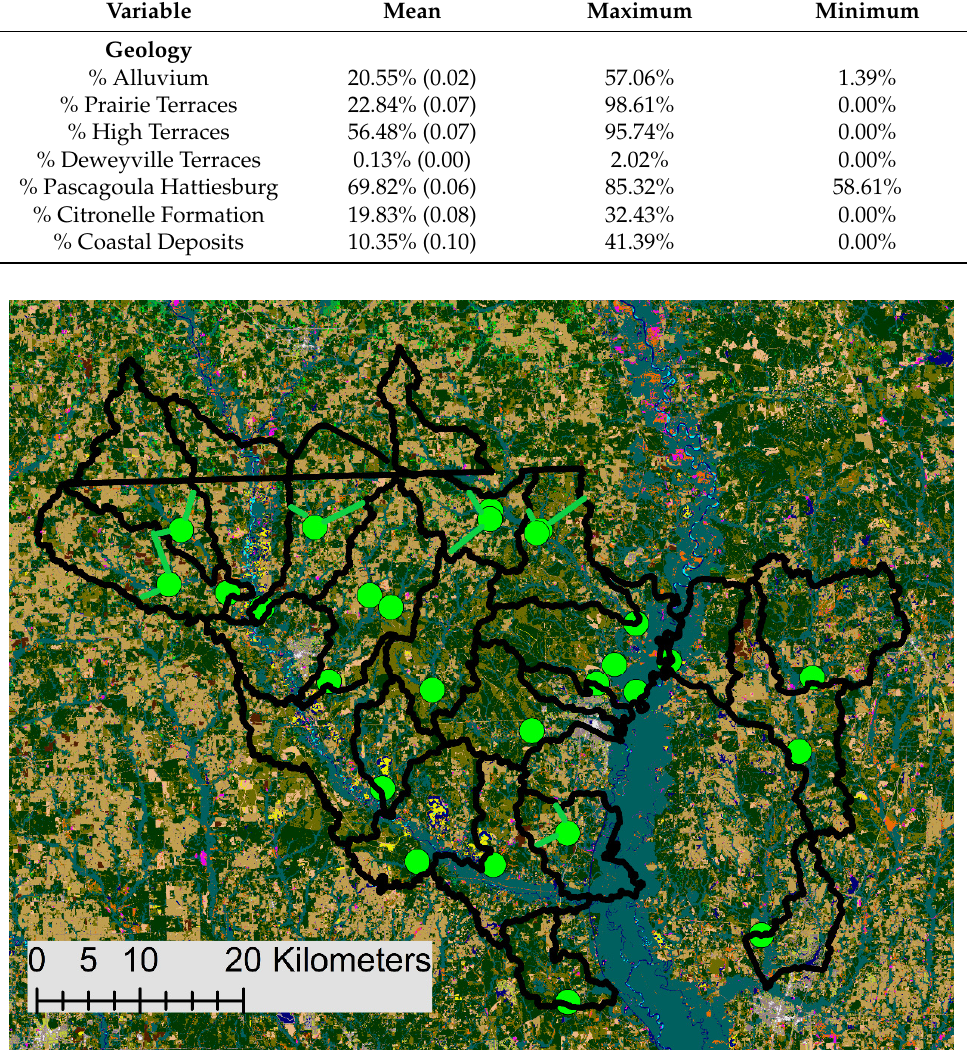
Figure 3. Watershed boundaries used to estimate land cover upstream of sampling sites (green circles). Boundaries (black lines) determined from U.S. Geological Survey hydrological units (12 digits codes). Green lines indicate the portion of the watershed upstream of some sampling sites that was analyzed. Otherwise, the entire upstream contributing watershed area was used. Land cover was obtained from U.S. National Oceanic and Atmospheric Agency 2010 C-CAP Regional Land Cover. Land cover types were developed (orange), water (dark blue), agriculture (tan), deciduous forest (light green), evergreen forest (dark green), mixed forest (olive green), wetland (light blue), and barren (yellow).